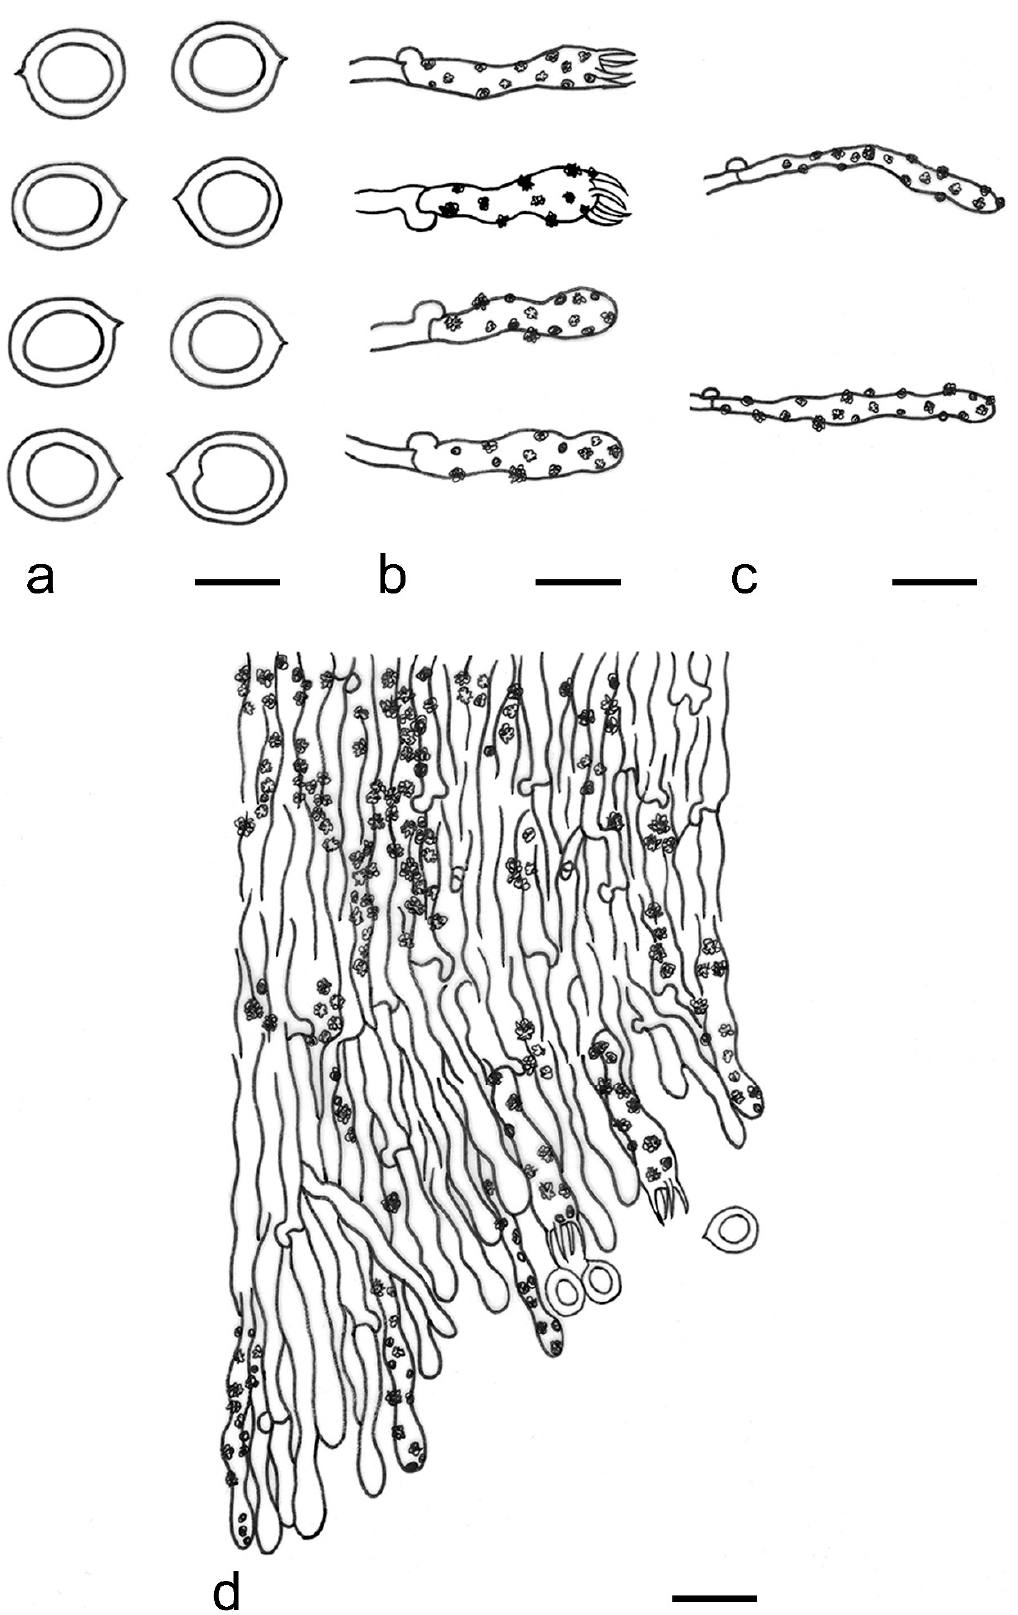
Figure 29. Microscopic structures of Xylodon rhododendricola (drawn from the holotype). ( a ) Basidiospores; ( b ) basidia and basidioles; ( c ) leptocystidia; ( d ) a section of the basidiocarp.—Scale bars: a = 5 μ m; b–d = 10 μ m.